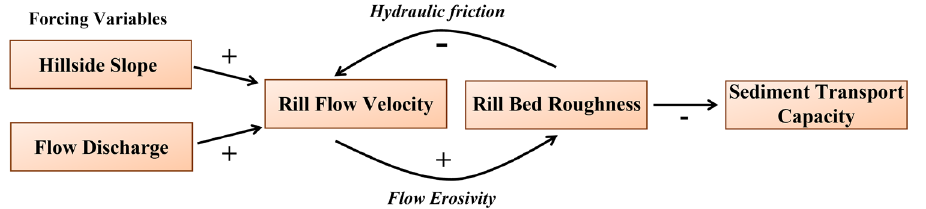
Figure 1. Feedback between rill-flow hydraulics and rill-bed roughness regulate sediment transport capacity. Rill flow velocity increases with hillside slope and flow discharge; rill bed roughness increases due to greater flow erosivity; and rill flow velocity decreases due to greater hydrologic friction, thereby counteracting the initial increasing impact of hillside slope. This feedback mechanism results in reduced erosivity and sediment transport capacity of an established